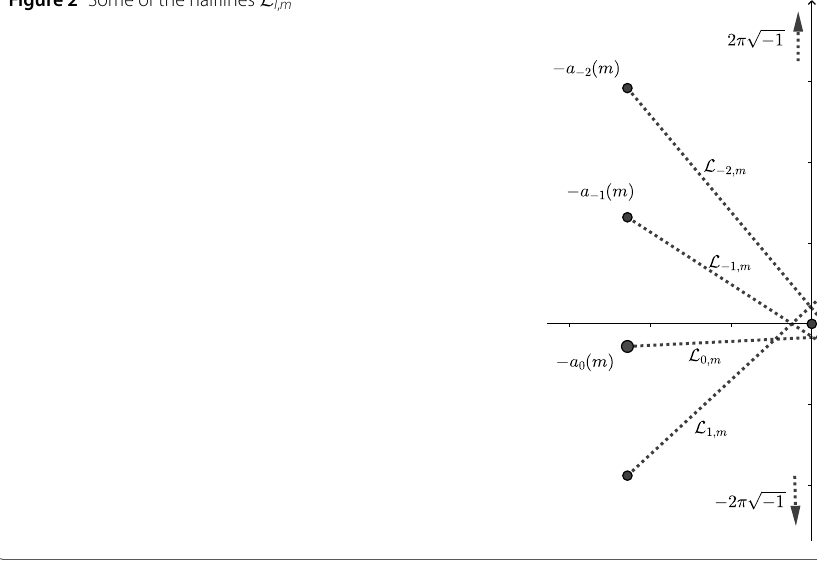
Figure 2 Some of the halflines L l ,